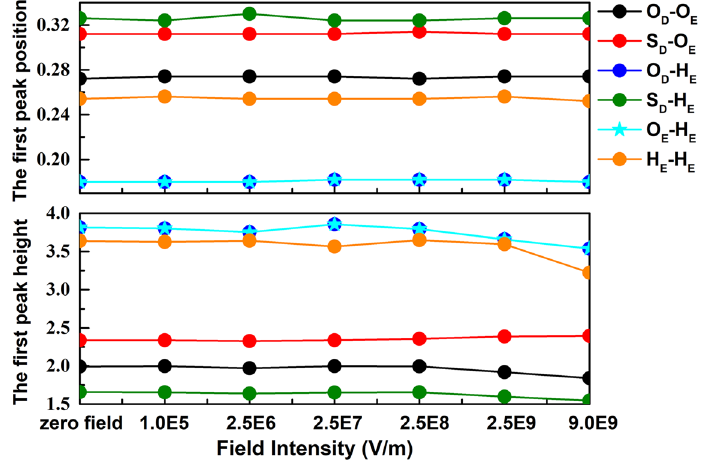
Figure 2. The position and the height of the first peaks of radial distribution functions for pairs in DMSO- ethanol mixture as a function of external field intensity: ( a ) O D -O E ; ( b ) S D -O E ; ( c ) O D -H E ; ( d ) S D -H E ; ( e ) O E -H E and ( f ) H E -H E . Where H E is the hydrogen atom of the hydroxyl group of ethanol